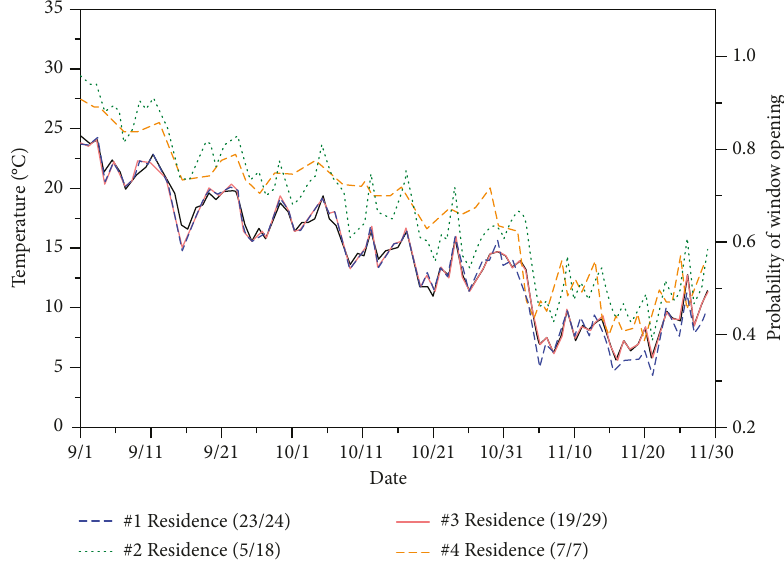
Figure 9: Probability change chart of window opening for different building